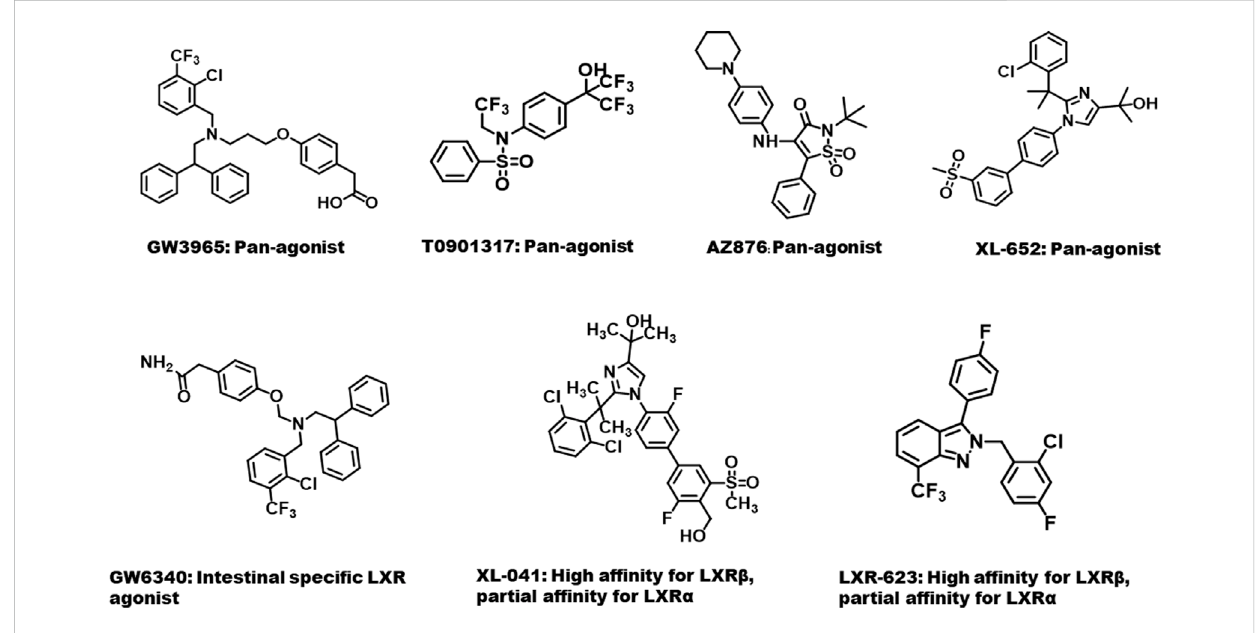
FIGURE 4 Structures of several mostly studied synthetic liver X receptor